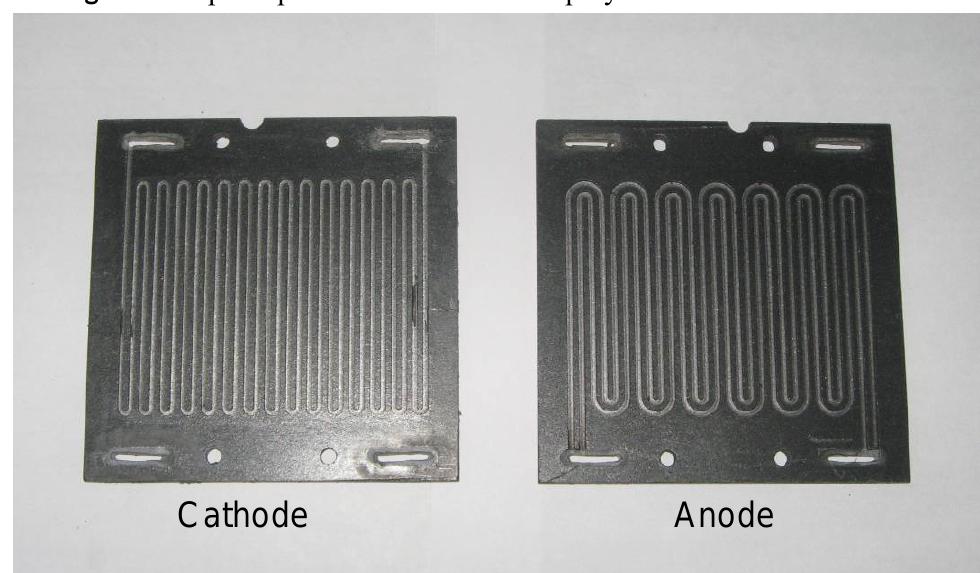
Figure 7. Bipolar plate with flow field employed for the DBFC stack.